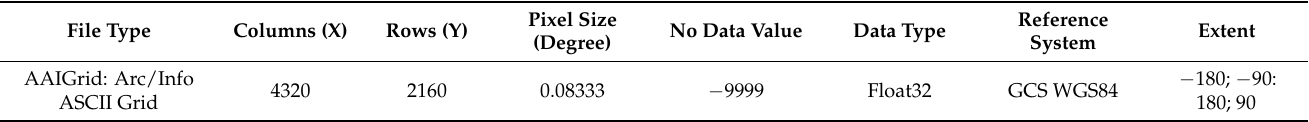
Table 1. Grid specification (data from GlobWat user manual